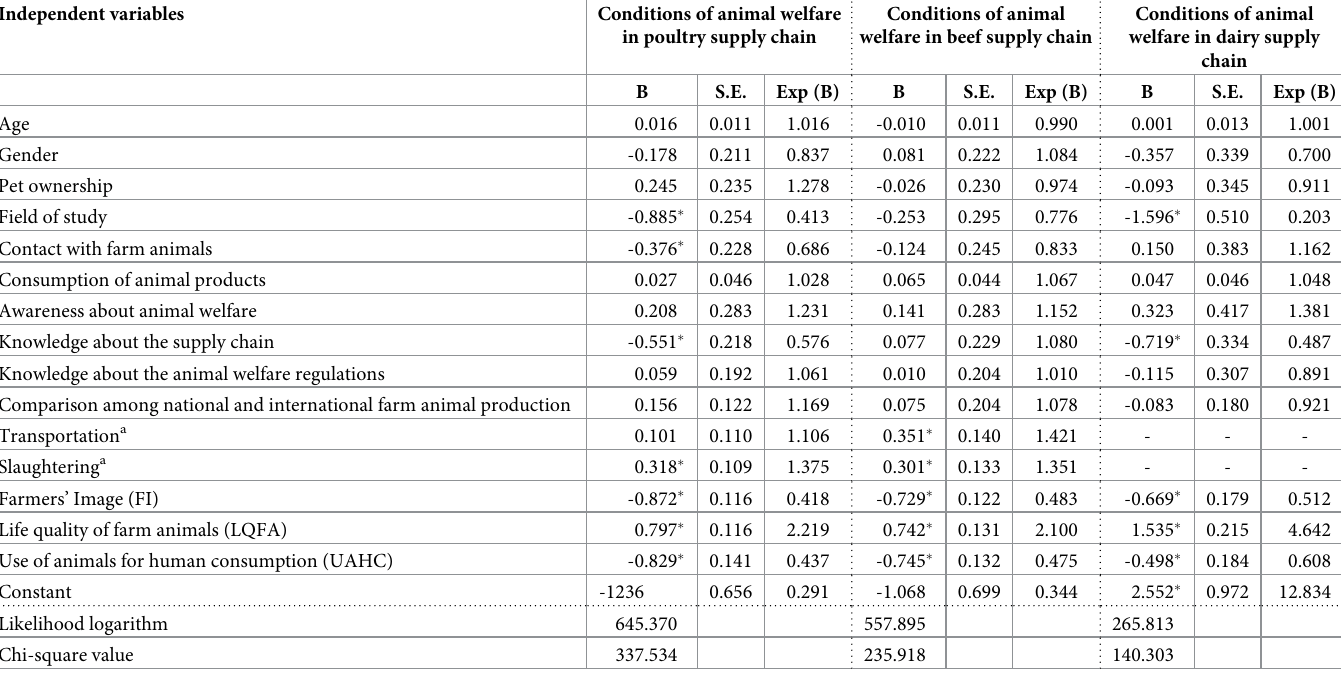
Table 2. Logistic regression models of the Brazilian citizen perceptions about the conditions of animal welfare on poultry, beef, and dairy supply chains. Independent